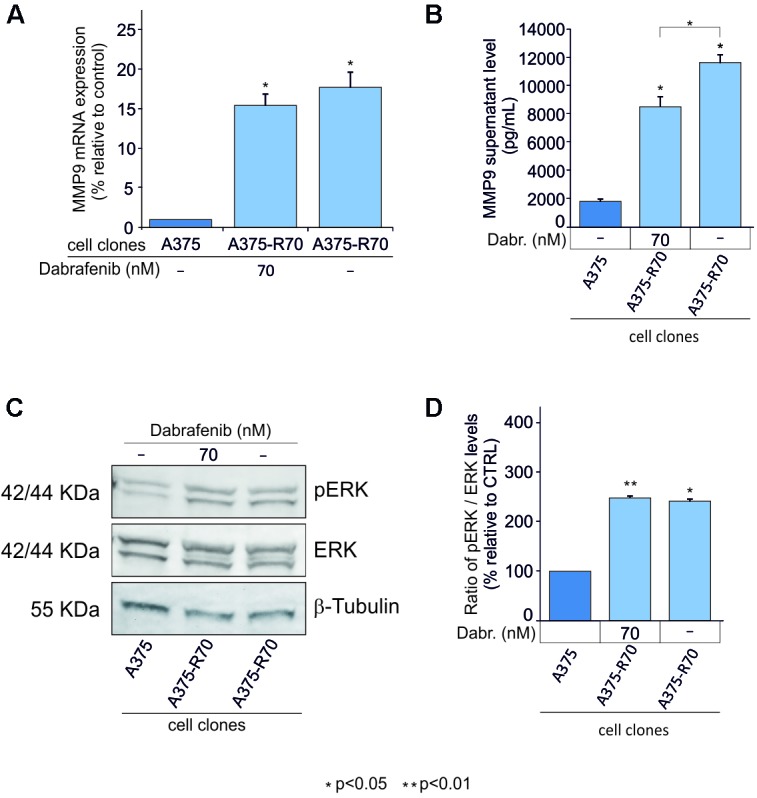
MMP-9 expression in A375 cell resistant to dabrafenib. MMP-9 expression levels were evaluated in, A375 parental clone, A375 dabrafenib resistant clones with and without addition of 70 nM of dabrafenib to RMPI-1640 medium (A,B). Western Blot analysis was performed to evaluate pERK levels in resistant clones e control cell line after 48 h (C,D). The statistical significance of the two-tailed Student’s t-test was referred to the control. ∗p < 0.05; ∗∗p < 0.01.